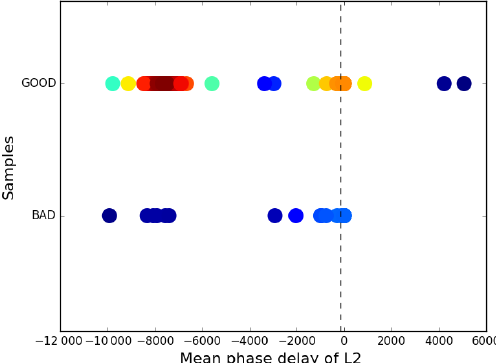
Figure 15. Global bending angle departure results, as a function of impact height for the mean bias. The green, red, blue and black lines are representative of setting occultation for GNOS, rising occulta- tion for GNOS, setting occultation for GRAS-A and rising occulta- tion for GRAS-A. O is observation and B is